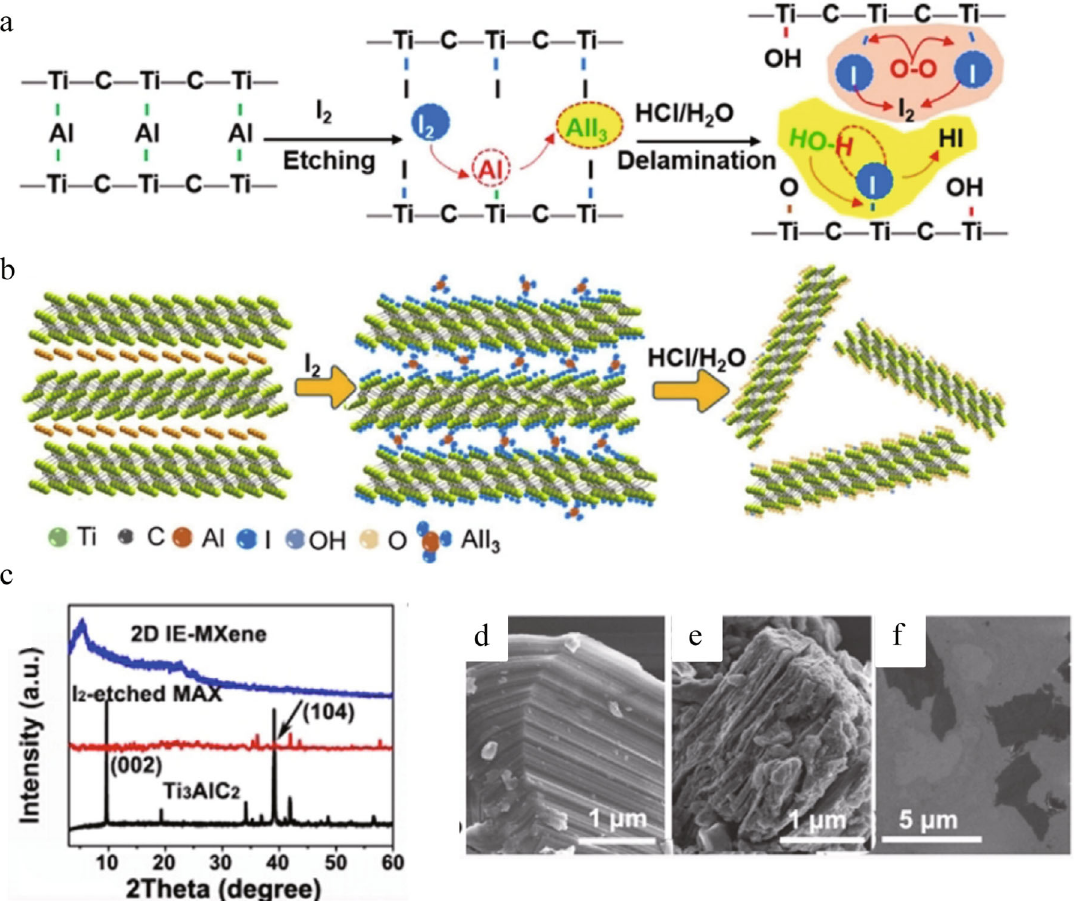
Fig. 6 The synthesis of MXenes from MAX phase by non-aqueous iodine-assisted etching. a , b The iodine-assisted etching and delamination of